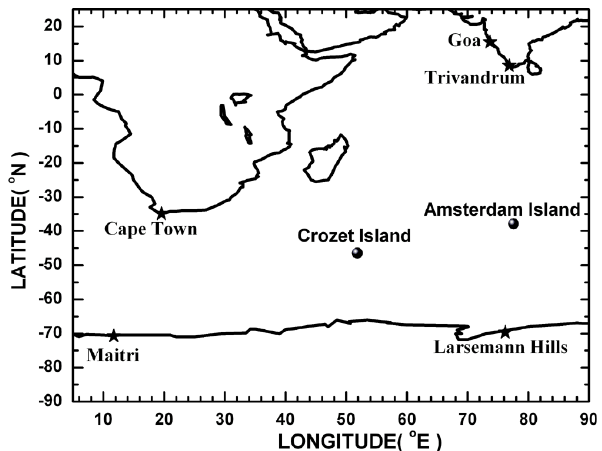
Fig. 1. The geographical location of the Indian stations Maitri, Larsemann Hills (site for third Indian station in Antarctica) and two AERONET stations Amsterdam and Crozet Islands in South- ern Ocean. The location of Trivandrum, Goa and Cape Town is also